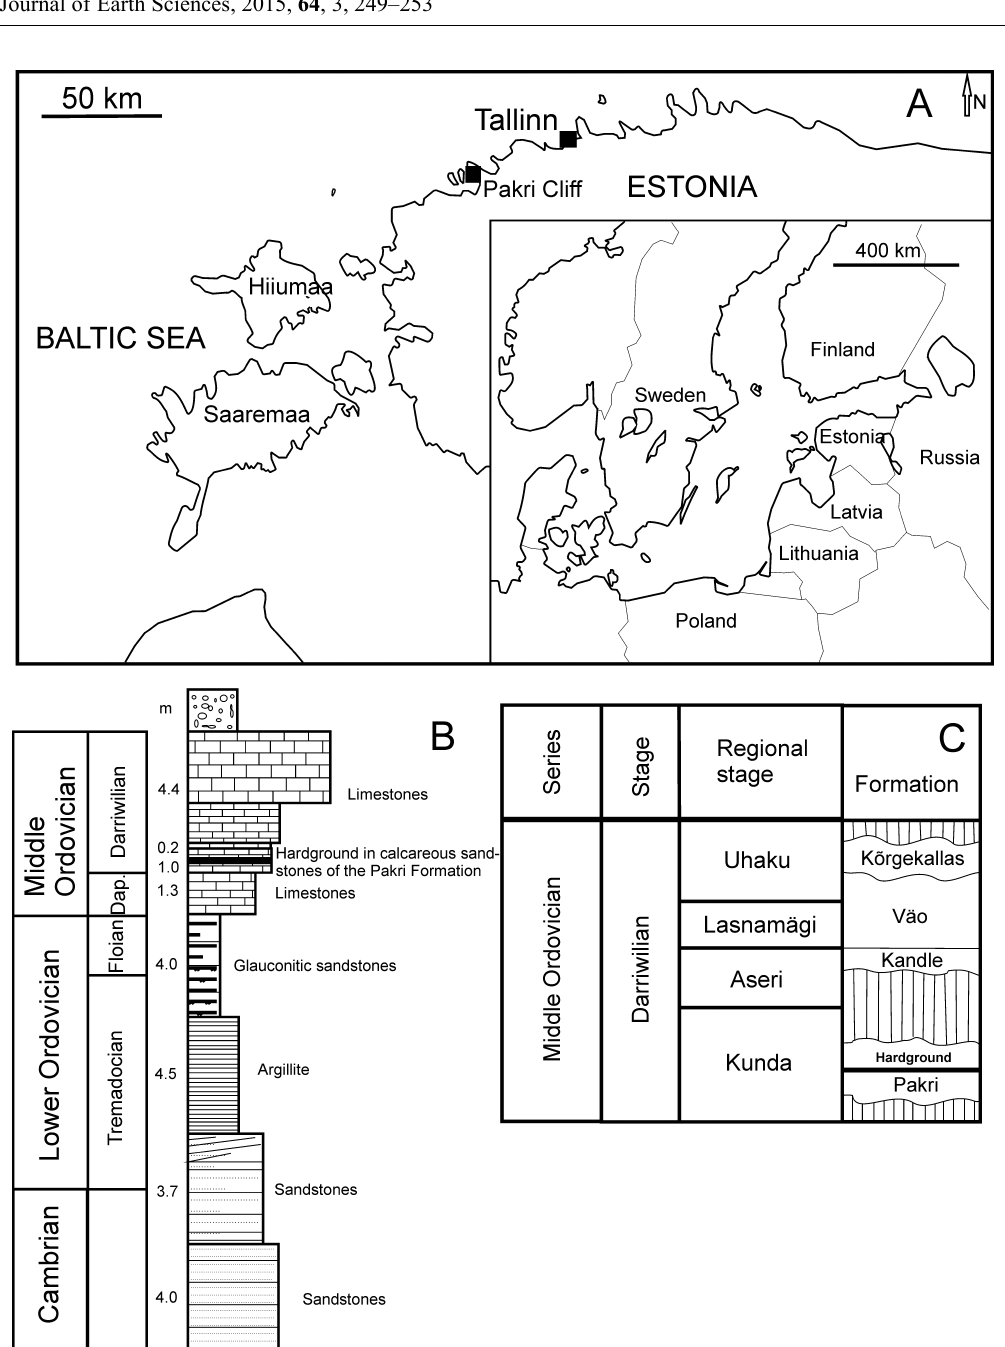
Fig. 1. A , location of Pakri Cliff in NW Estonia. B , Pakri Cliff with the studied hardground in the Pakri Formation (Darriwilian). Modified after Hints et al. (2008). C , the Middle Ordovician in Estonia. Location of the hardground within the Pakri Formation. Modified after Hints et al.